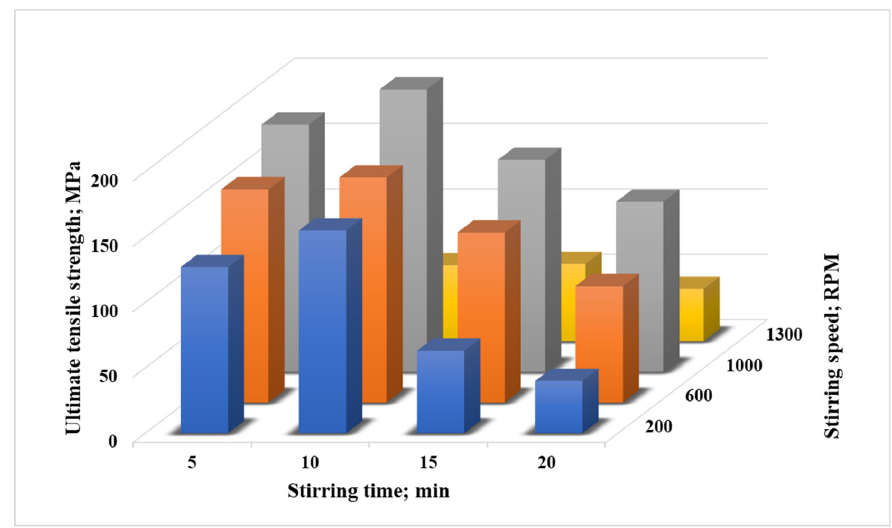
Figure 3. Ultimate tensile strength values for Al6061/TiO 2 (1 wt.%) stirred at different speeds and duration times.